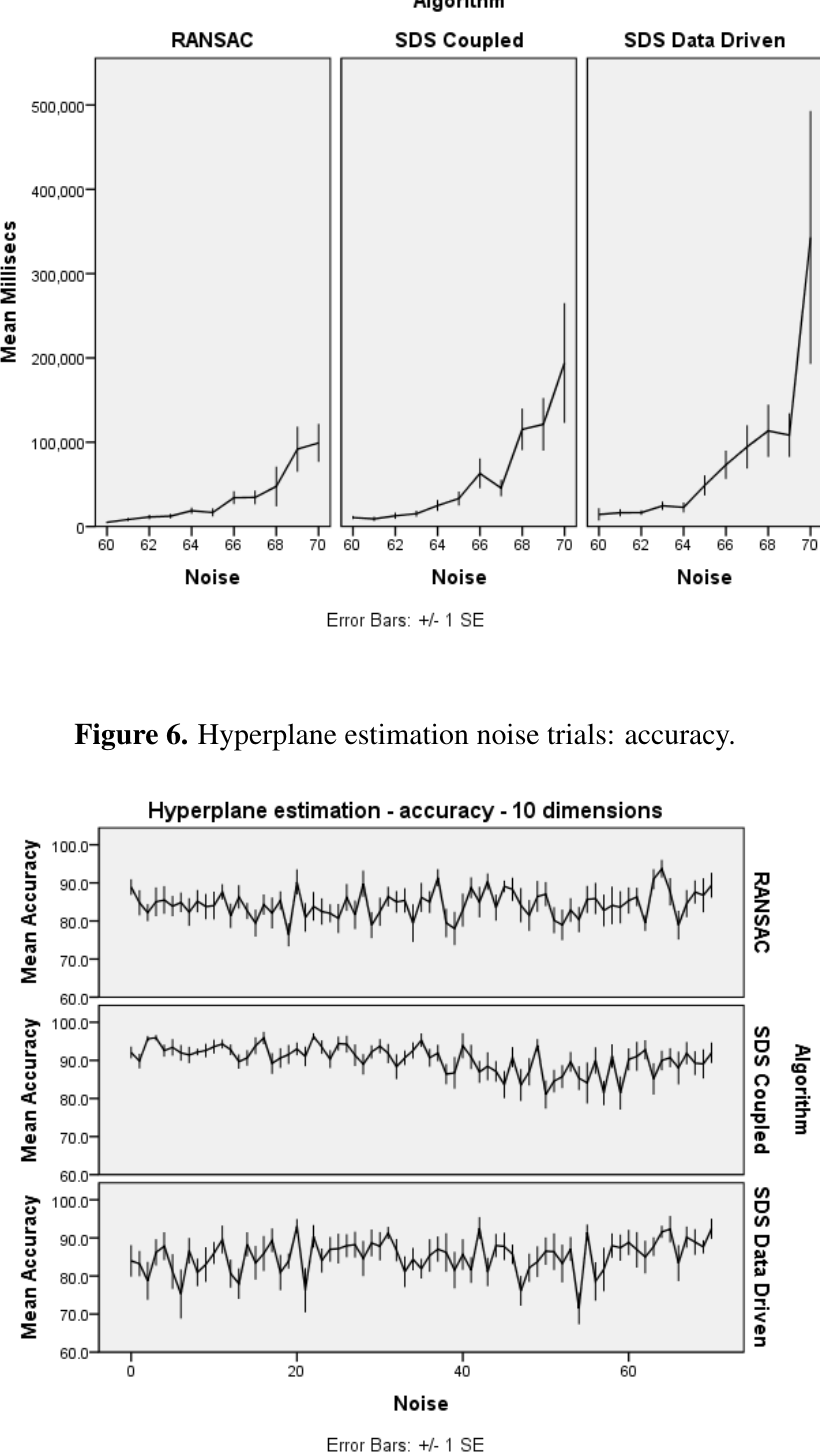
Figure 5. Hyperplane estimation noise trials: convergence time.